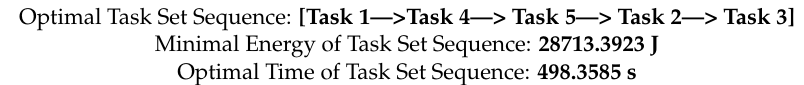
Table 8. Simulation results for multi-task flow optimal task sequence